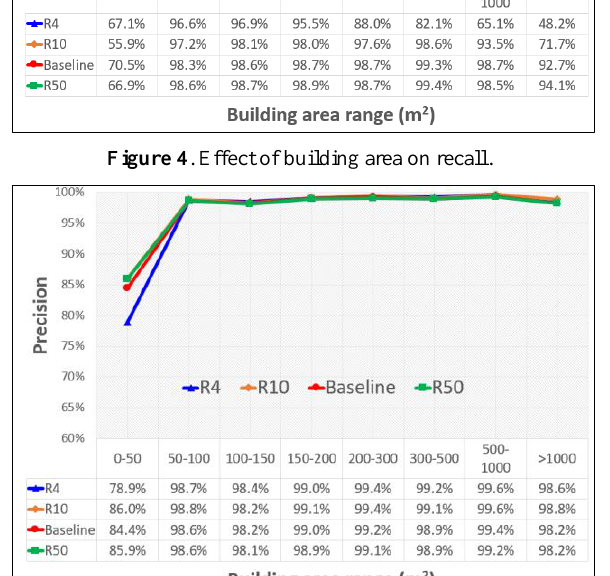
Figure 5 . Effect of building area on precision.